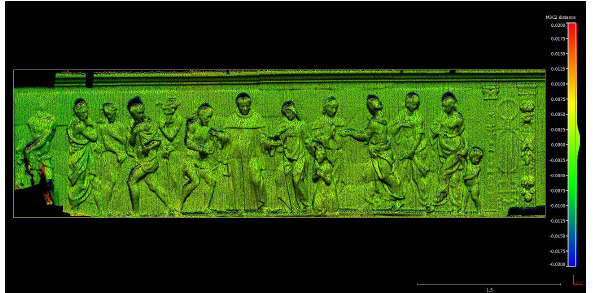
Figure 11. The outcome of the auto-calibration project demonstrates a very good conformity with the scan data assumed as the reference – Step 4